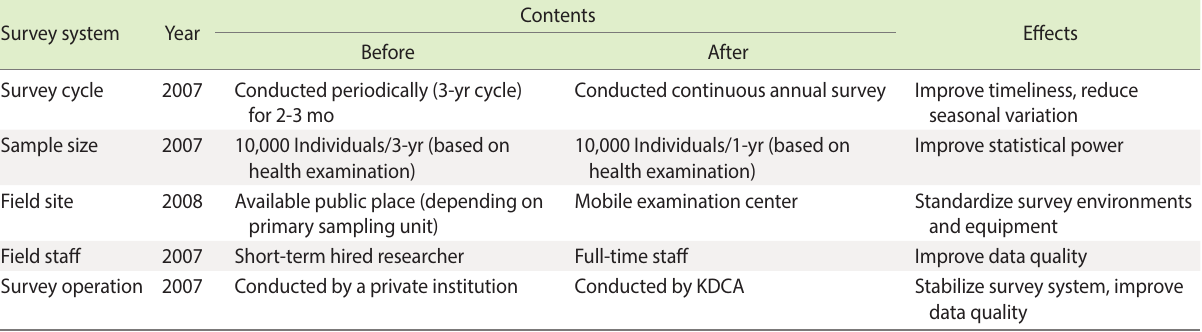
Table 1. Reorganization of the Korea National Health and Nutrition Examination Survey Survey system